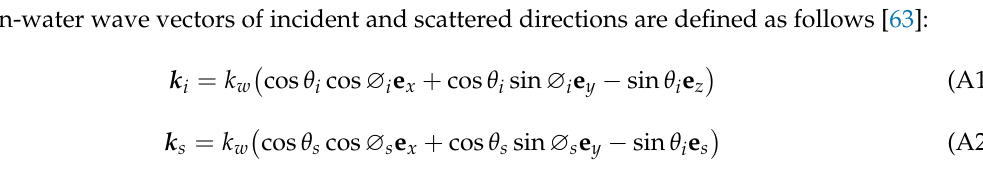
Figure A1. Definition of angle of incident and scattered waves.